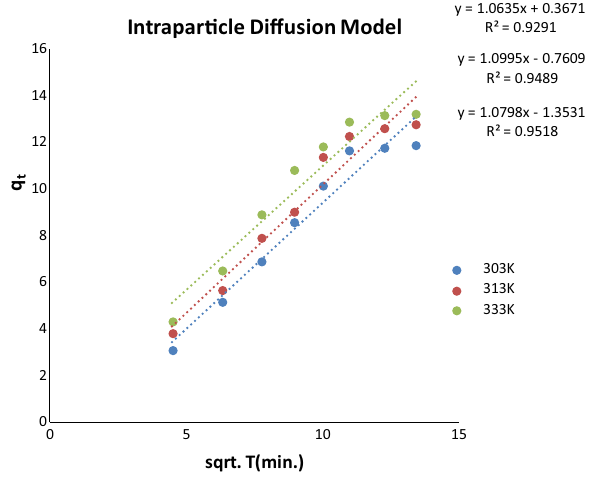
Fig. 21 Intraparticle diffusion model. Temperature—30, 40, 60